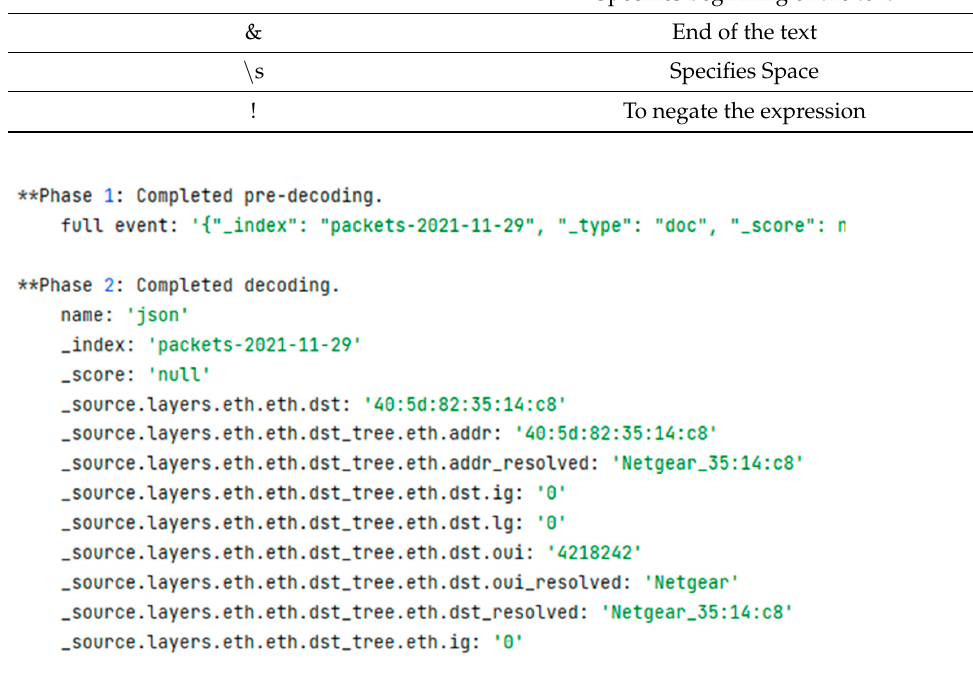
Figure 12. Decoder